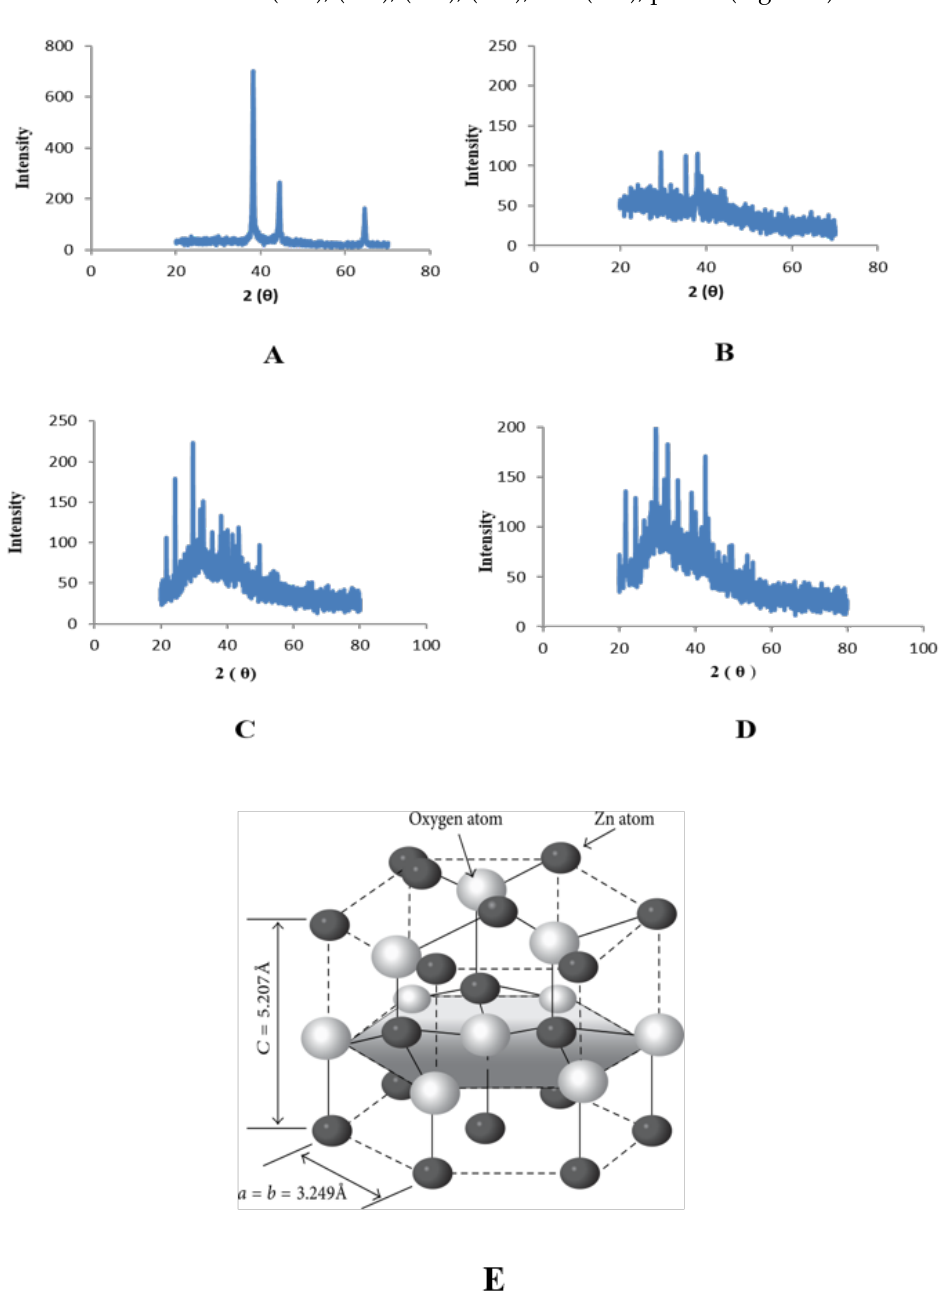
Figure 6. XRD peaks of zinc oxide nanoparticles of leaves; ( A ) n-Hexane ( B ) Ethyl Acetate ( C ) Methanol ( D ) Aqueous ( E ) The hexagonal wurtzite structure model of ZnO